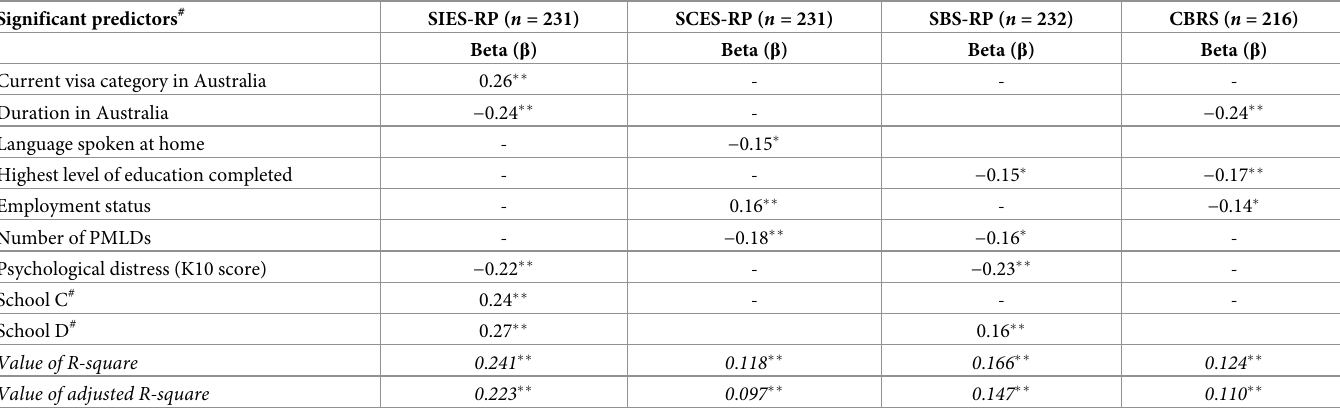
Table 6. Standardised LASSO (forward) regression coefficients (Beta, β ) for significant